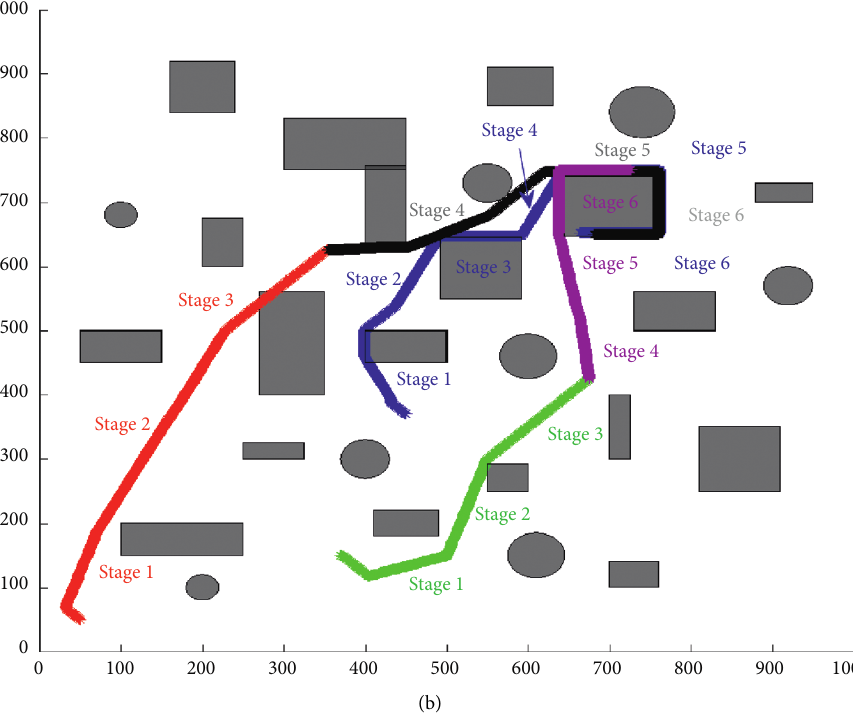
Figure 5: Collaborative pursuit-evasion game in complex 3D polygonal environment. (a) Top view of the paths along − z axis in METHOD I. (b) Top view of the paths along − z axis in METHOD